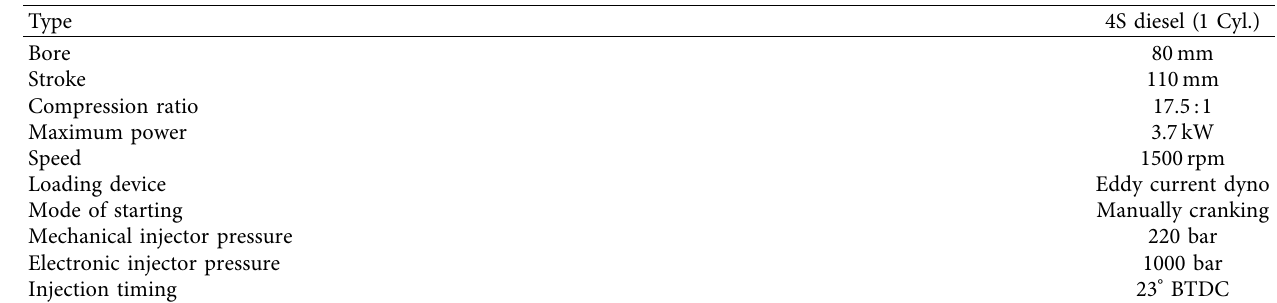
Figure 12: Experimental schematic of Lean NO Table 1: IC engine